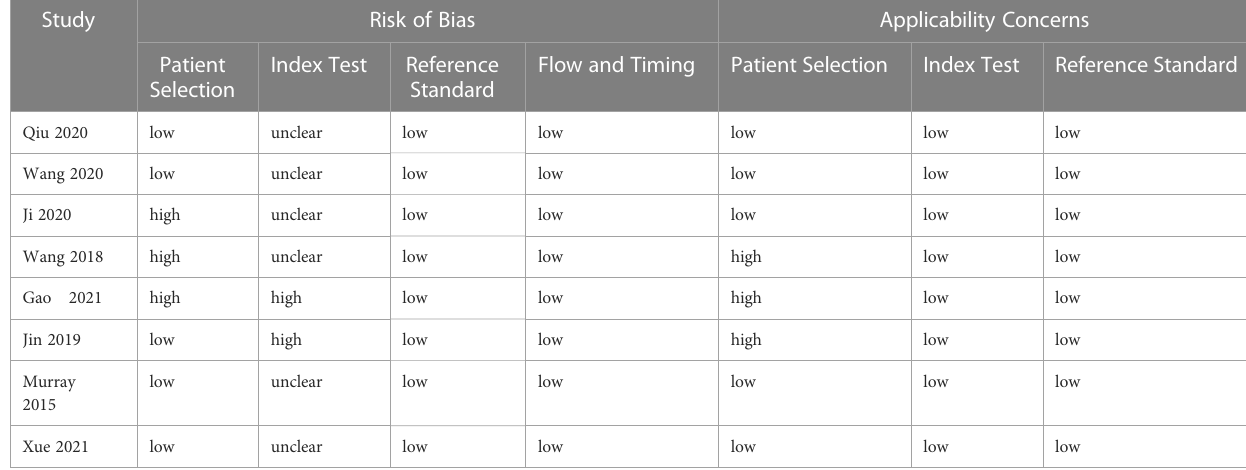
TABLE 2 The results of quality assessment of included studies in the